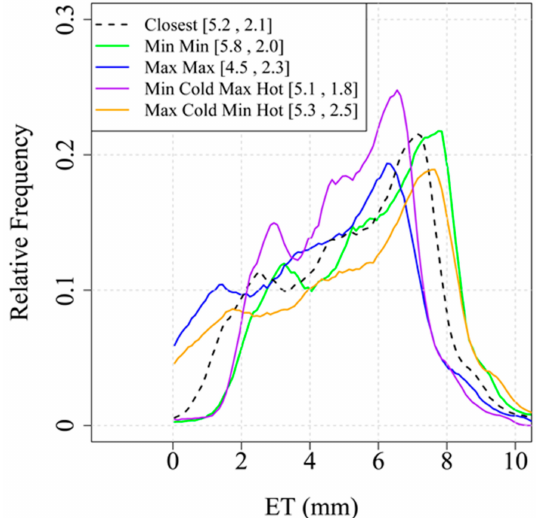
Figure 8. Frequency distribution of ET for different calibration sets for 2014-07-24. The values in the legends are, respectively, [Mean, standard